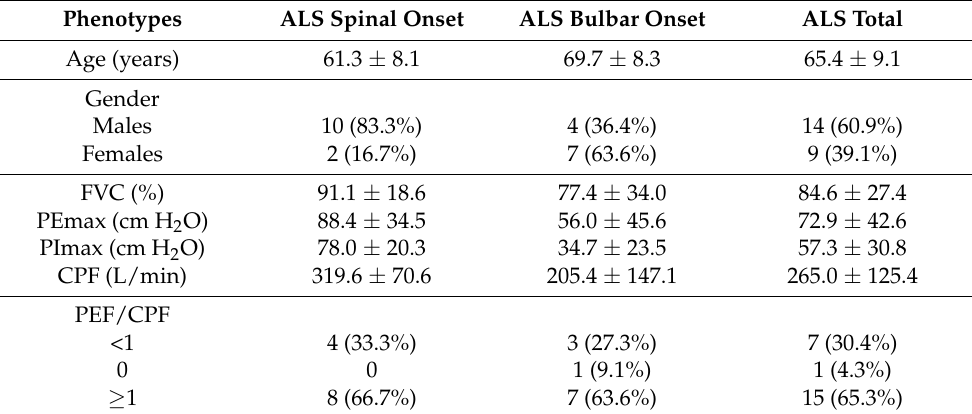
Table 1. Patient’s demographic data and respiratory function evaluation at